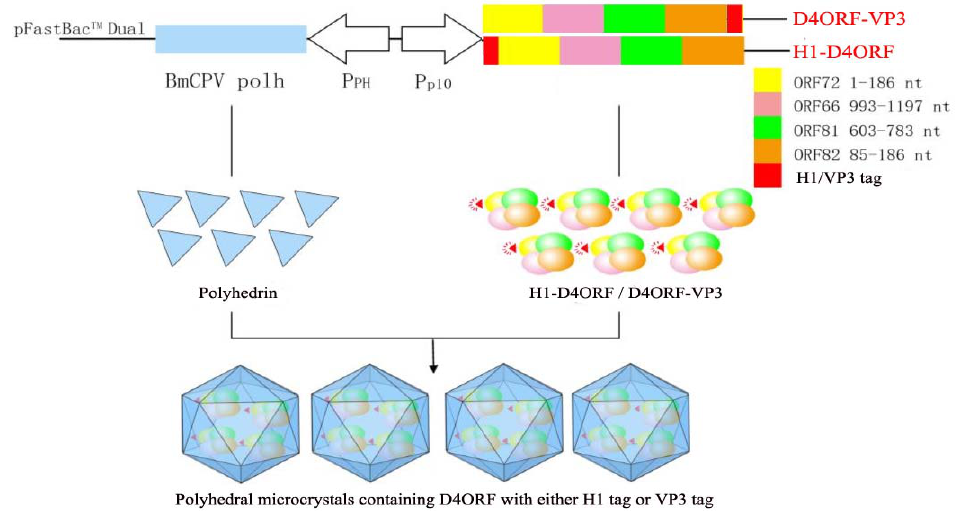
Figure 1. Strategies for constructing polyhedral microcrystals encapsulating antigen protein of CyHV-2. A codon-optimized sequence, D4ORF, comprising the ORF72 (region 1–186 nt), ORF66 (region 993–1197 nt), ORF81 (region 603–783 nt), and ORF82 (region 85–186 nt) genes of CyHV-2 was synthesized. The H1-D4ORF and D4ORF-VP3 sequences were, respectively, obtained by fusing the H1-helix sequence (region 1–90 nt) of the BmCPVpolh to the 5 (cid:48) terminal end of D4ORF and by fusing a partial sequence (1–279 nt) of the BmCPV VP3 gene to the 3 (cid:48) terminal end of D4ORF, respectively. The H1-D4ORF or D4ORF-VP3 sequences were driven by the baculovirus p10 promoter (Pp10). The BmCPV polh was controlled by the baculoviruspolh promoter (PPH). When either the H1-D4ORF or D4ORF-VP3 wasco-expressed with BmCPVpolh in the cell, the respective H1-D4ORF and D4ORF-VP3 proteins were incorporated into polyhedral